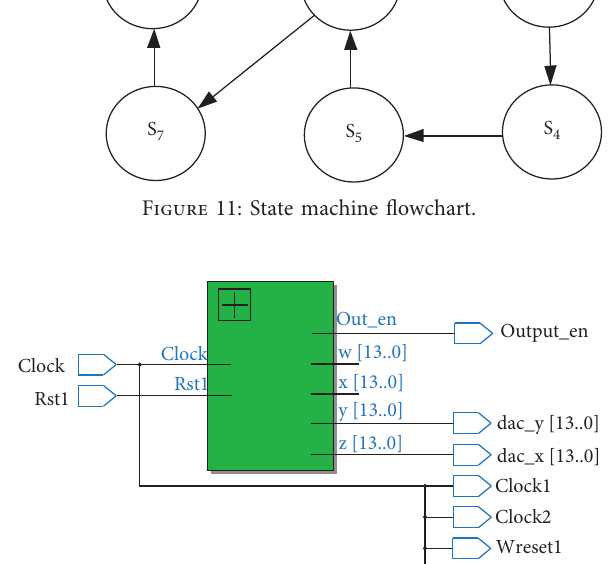
Figure 12: Top-layer RTL of the proposed chaotic system.